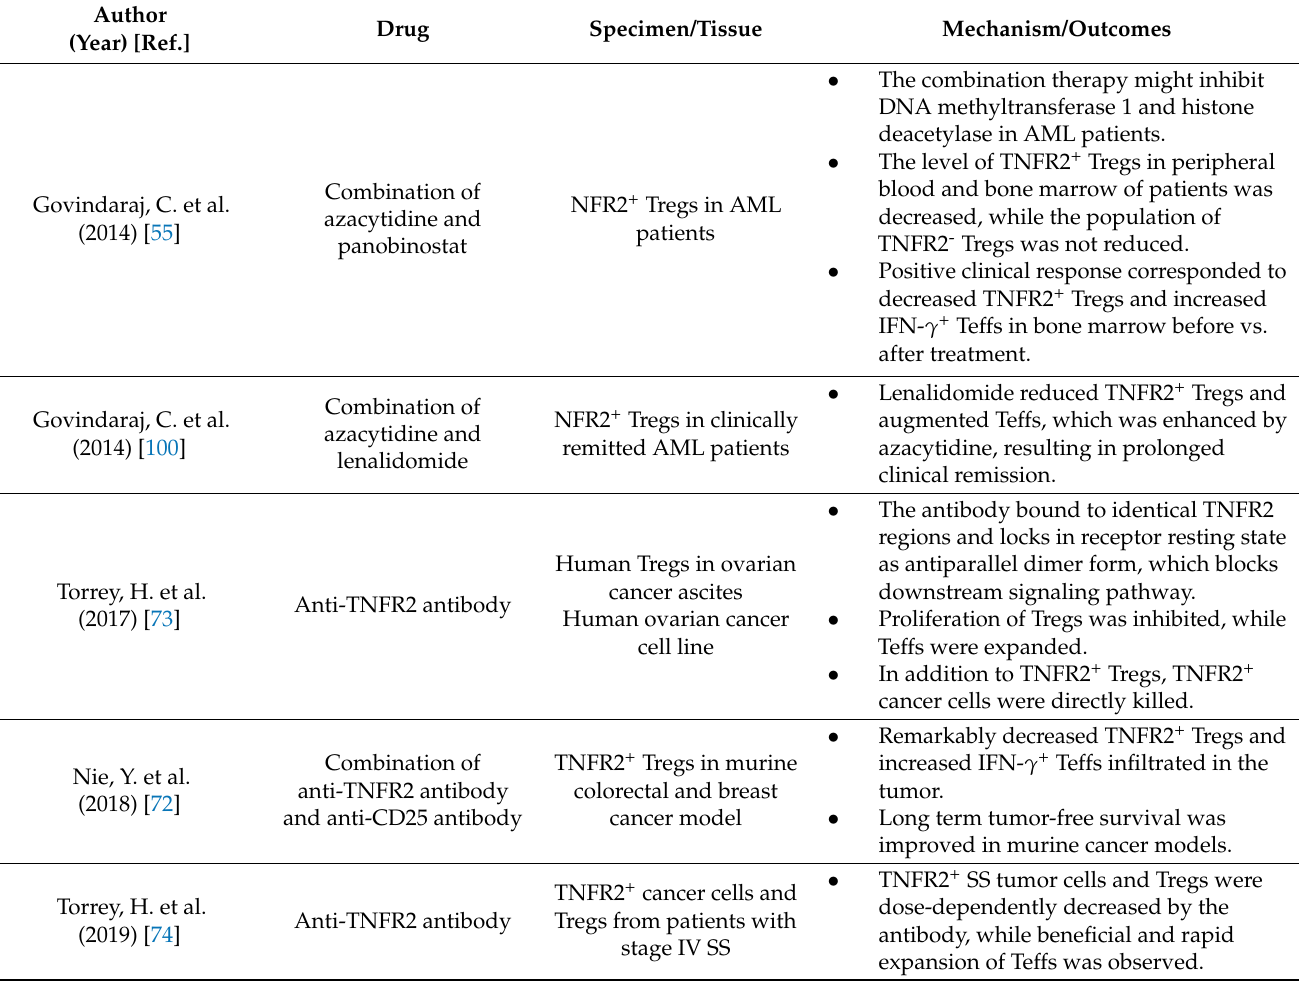
Table 3. Summary of studies using TNFR2-targeted therapy for malignant